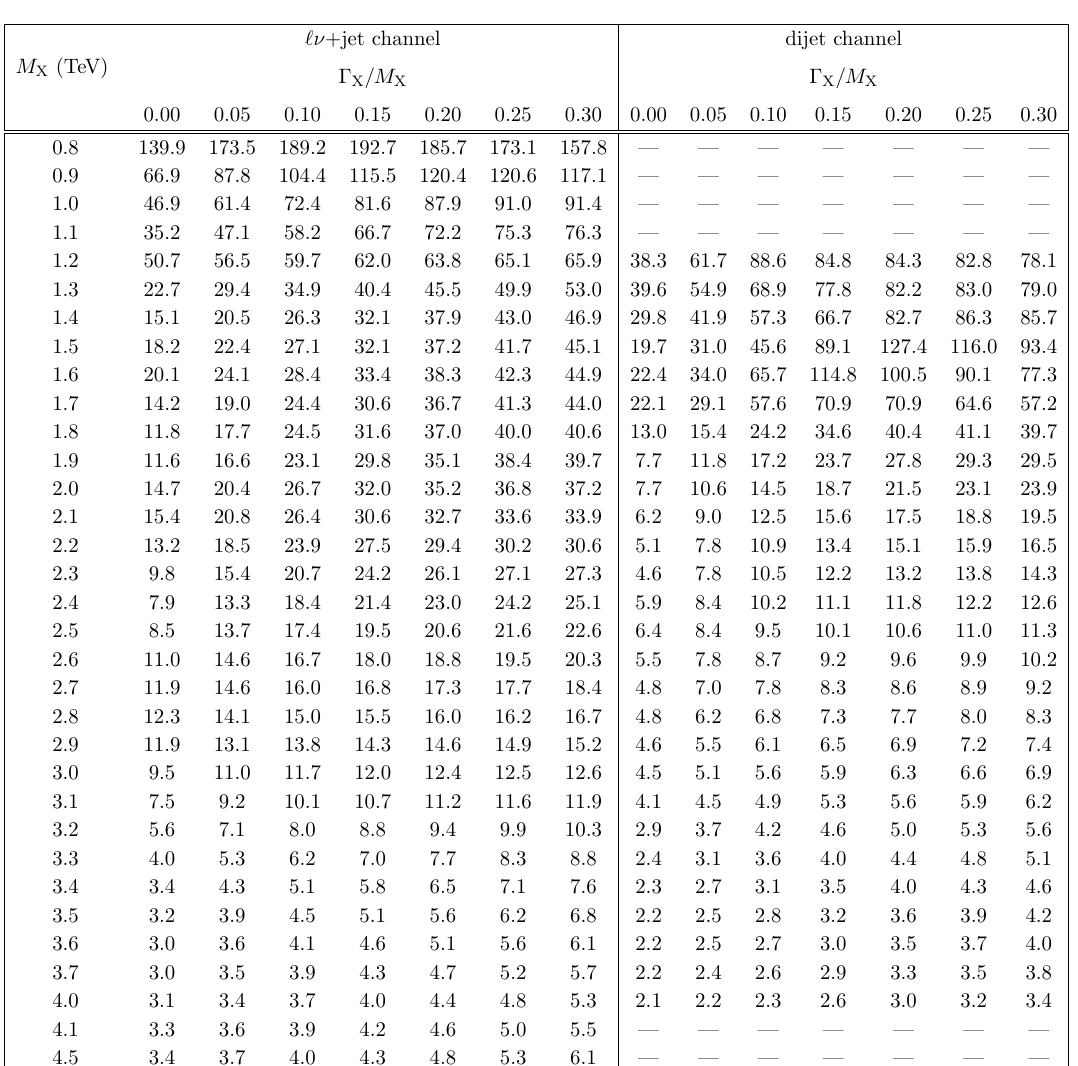
Table 14 . Simpli(cid:12)ed limits on the number of visible events from generic resonances decaying to pairs of V bosons in the ‘(cid:23) +jet (left) and dijet (right) channels as a function of resonance mass, M X , and normalized width, (cid:0) X =M X . Shown are limits on the visible number of events at 95% CL using the asymptotic CL S approach. Results with (cid:0) X =M X = 0 are obtained using the resolution function only.